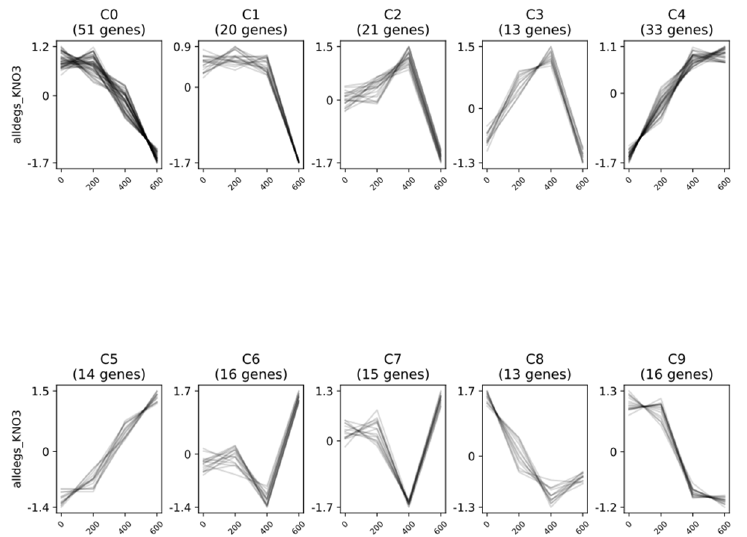
Figure 4. Pattern of expression of differentially expressed genes (DEGs) in non-nodulated Casuarina glauca plants supplied with KNO 3 (KNO 3+ ), grouped by predicted co-expressed gene clusters. Clustering analysis was performed by Clust tool with normalized reads from samples grown at 0, 200, 400, and 600 mM NaCl.